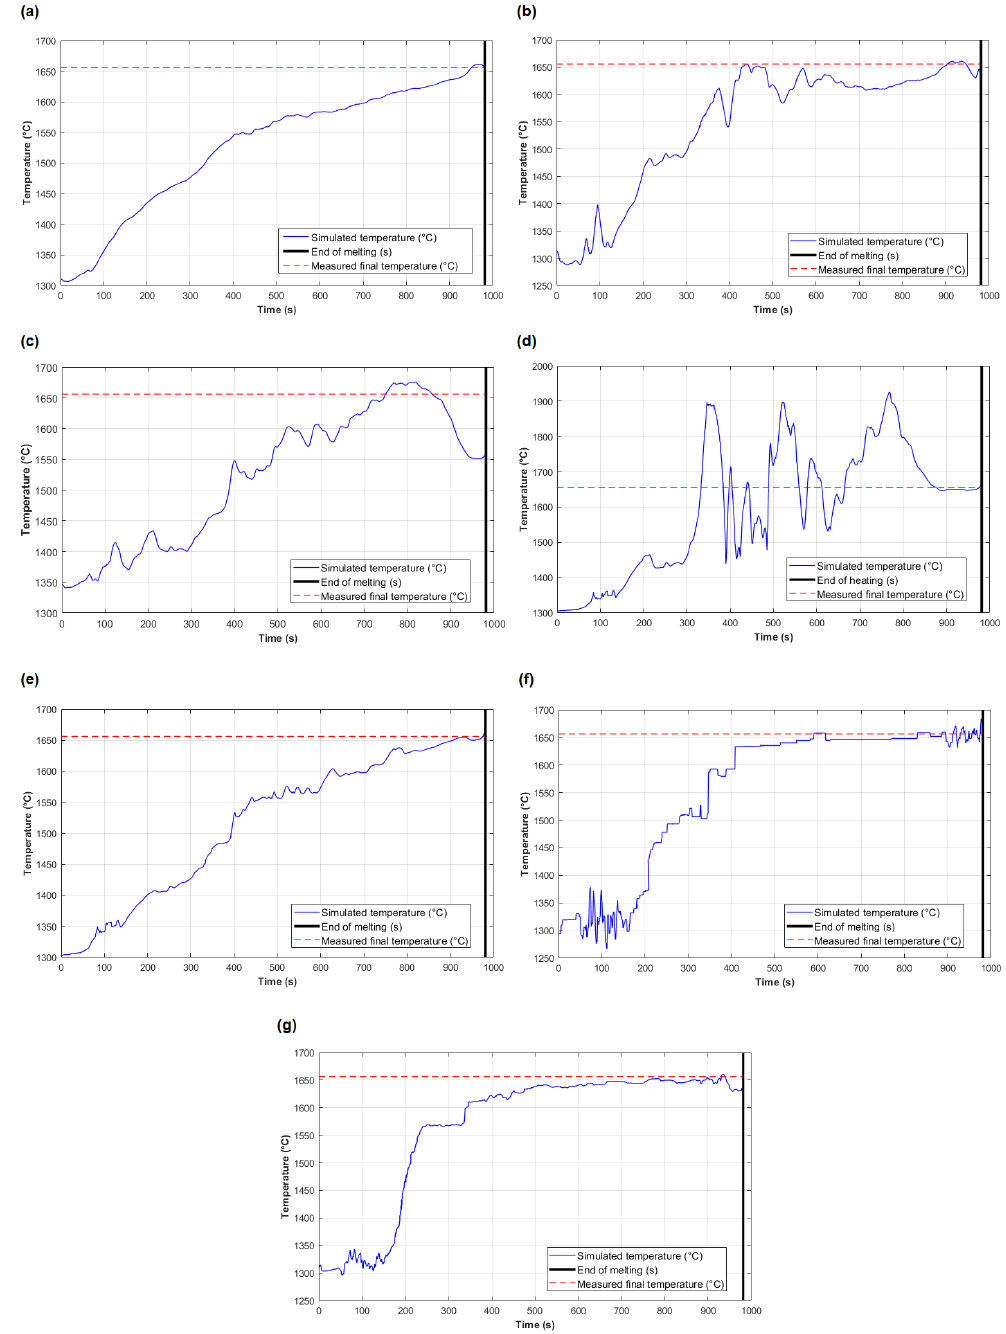
Figure 20. Prediction of melt temperature from dynamic observations by ( a ) SVR model with polynomial kernel, ( b ) SVR model with Gaussian kernel, ( c ) NN model, ( d ) piecewise-linear MARS model, ( e ) piecewise-cubic MARS model, ( f ) k -NN model, ( g ) RF